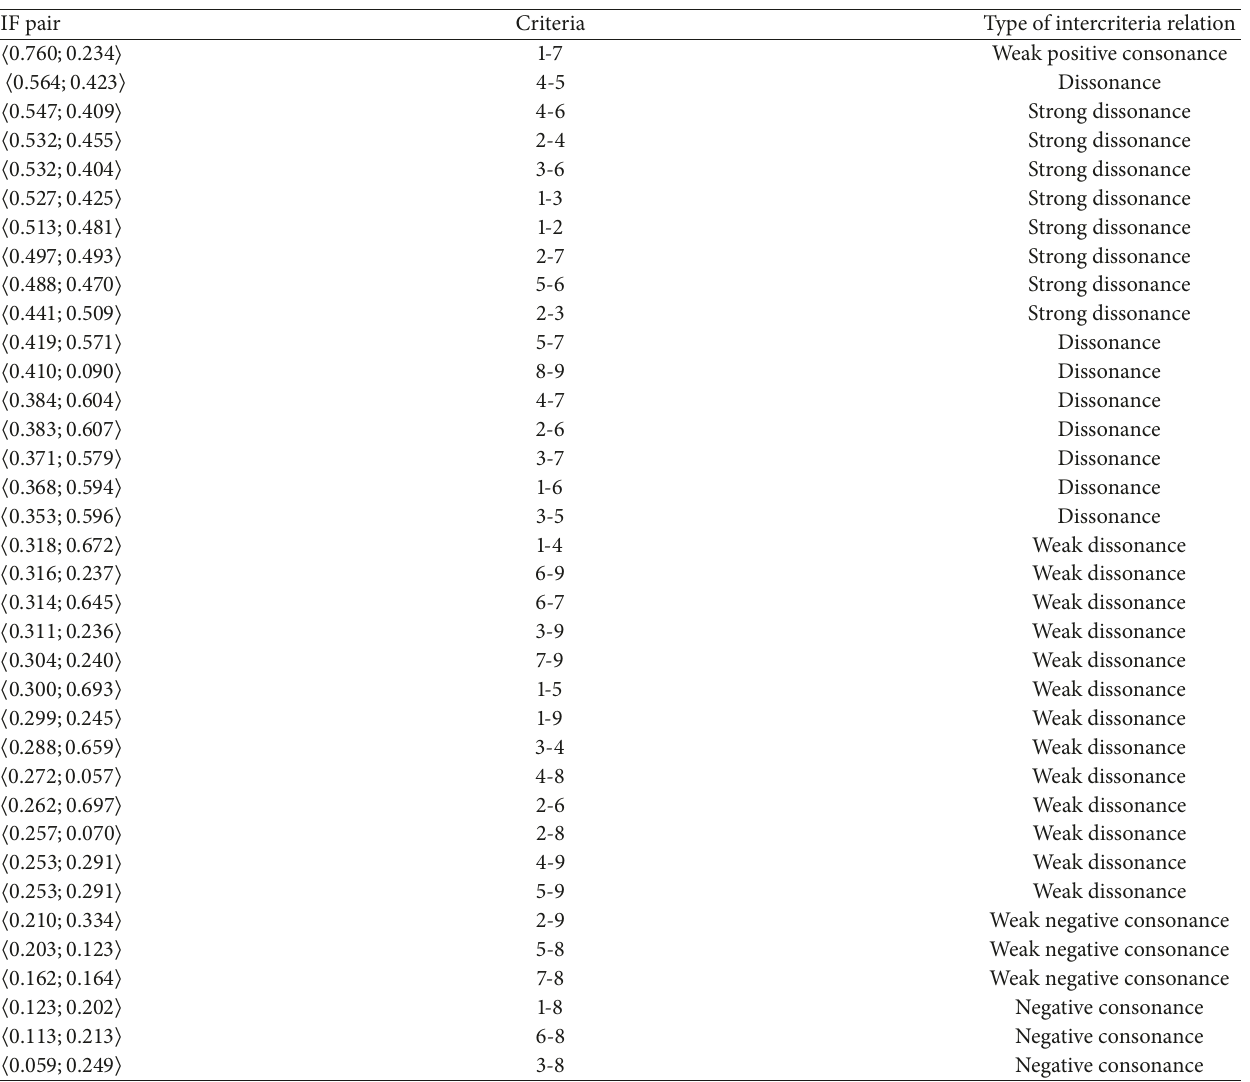
Table 9: Relations among the